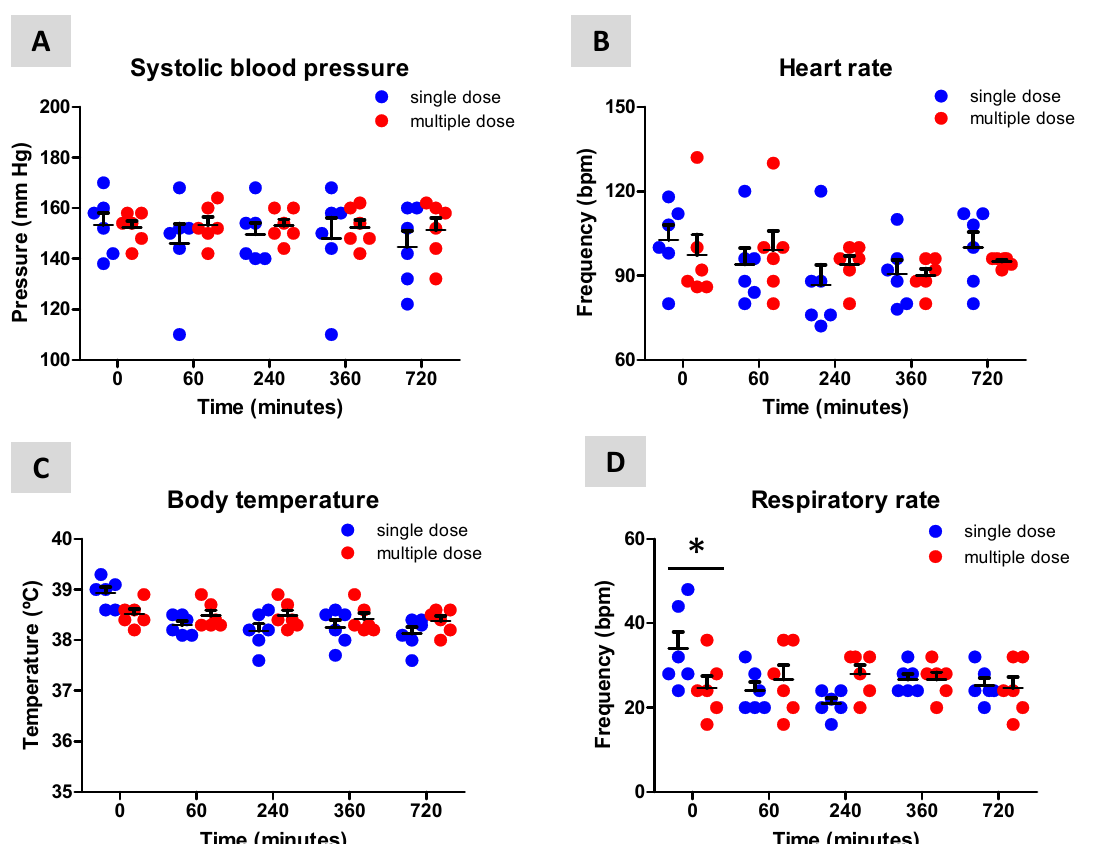
Figure 2. Effects of the single dose and multiple dose treatment with Sativex, delivered by sublingual administration (3 consecutive sprays equivalent to 8.1 mg of Δ 9 -THC and 7.5 mg of CBD), to naïve dogs on their systolic blood pressure ( A ), heart rate ( B ), body temperature ( C ) and respiratory rate ( D ). Values are means ± SEM of 6 animals per group. Data were assessed by using two-way ANOVA followed by the Bonferroni test (* p < 0.05 versus the single dose treatment).